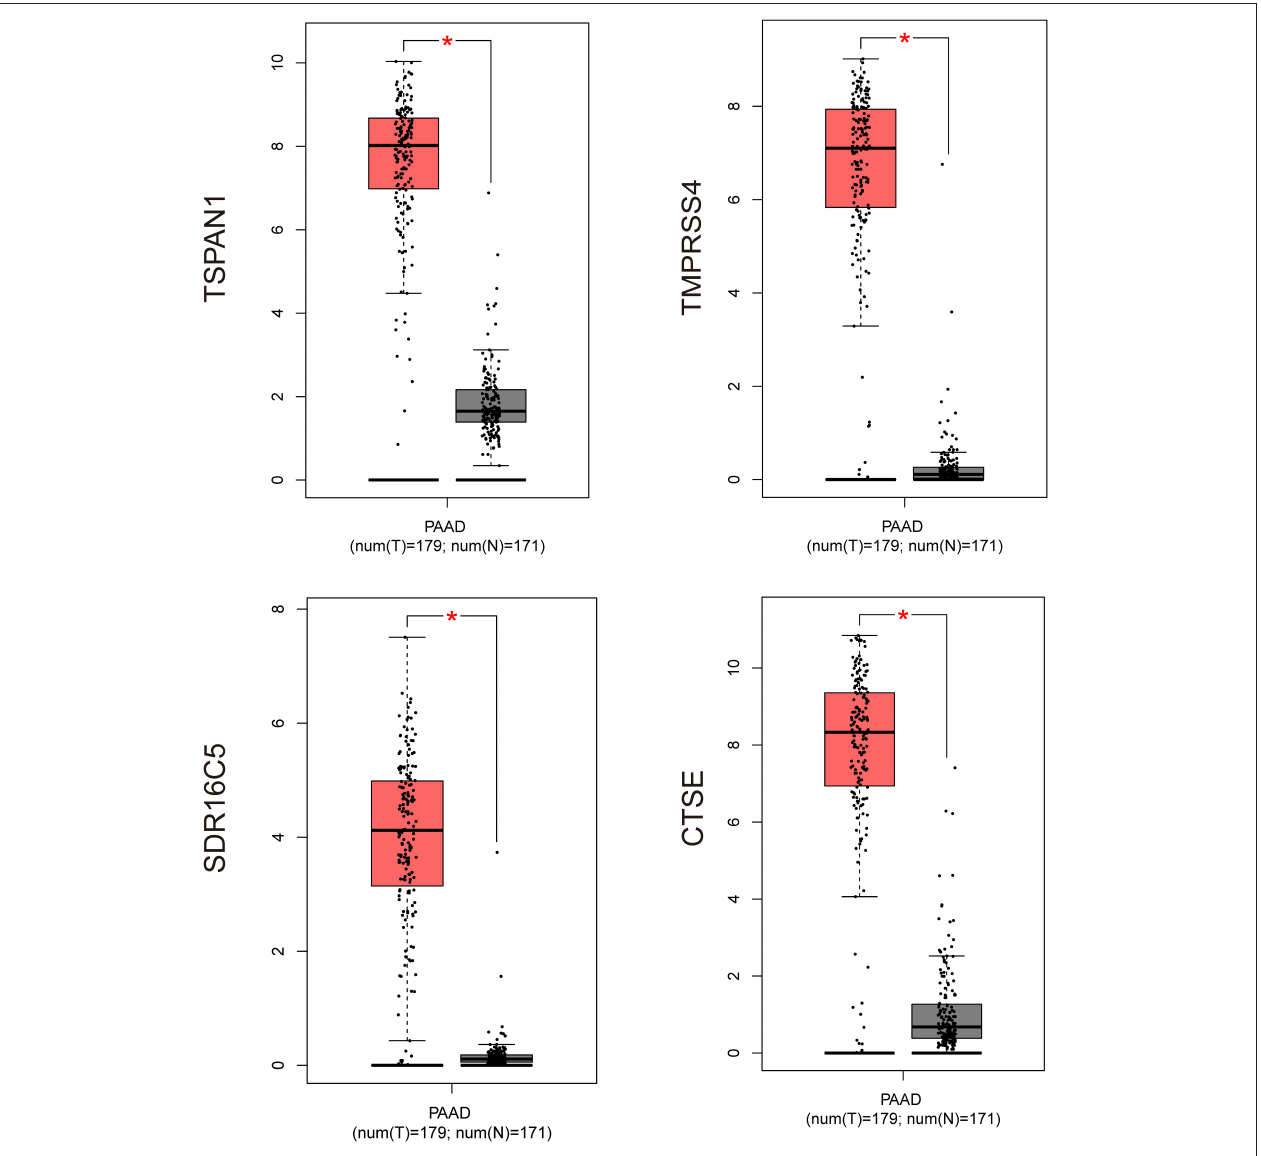
FIGURE 6 | Validation of four hub genes expression by using RNA-Seq data (GEPIA website). * P ≤ 0.05; PAAD, pancreatic cancer (GEPIA website).